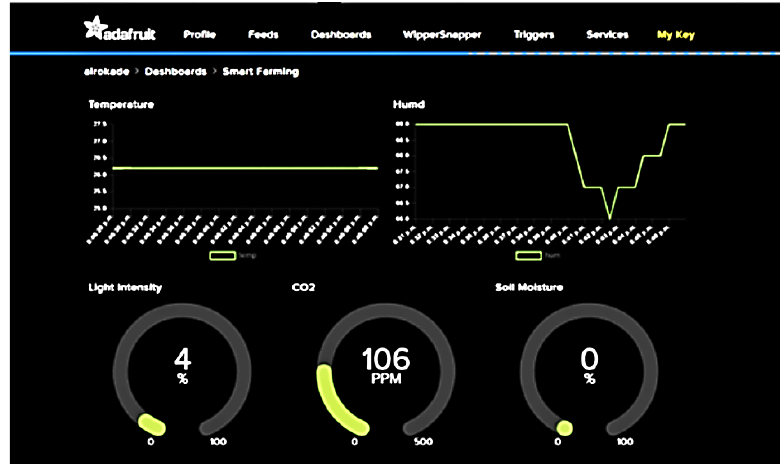
Figure 9. Sensor output on Adafruit IO Cloud IoT dashboard for Case 1.